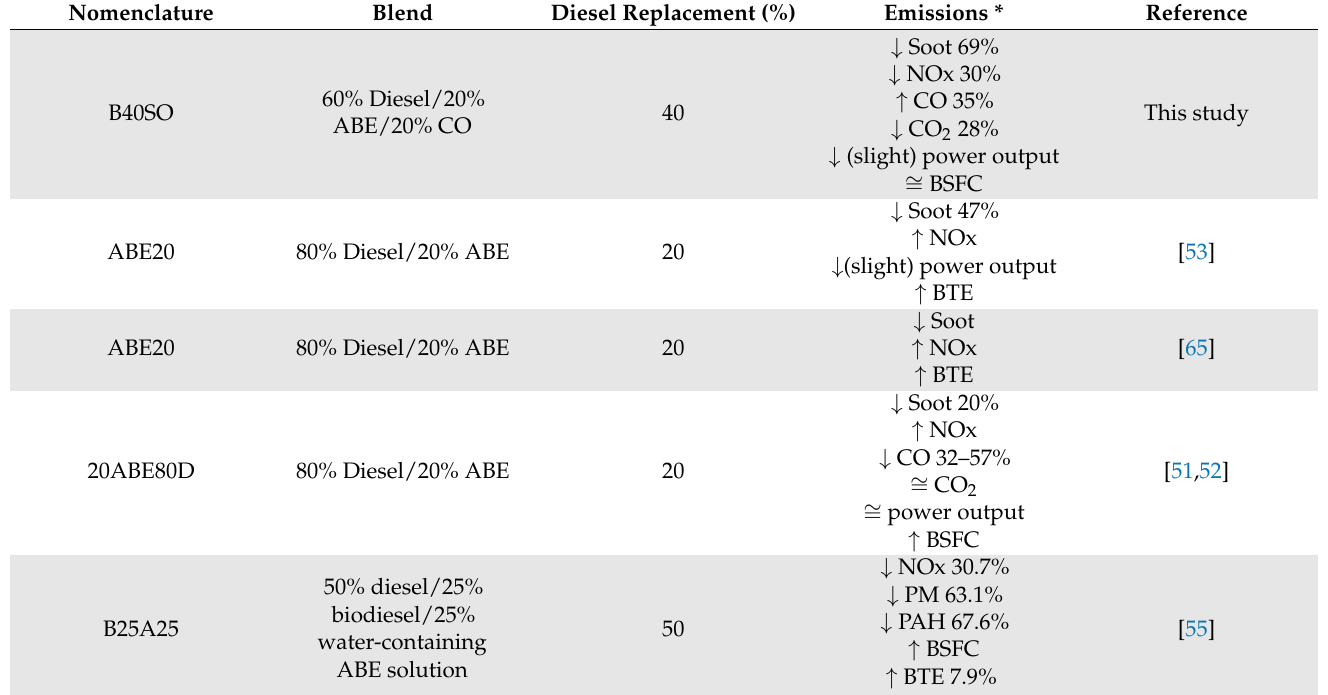
Table 7. Comparison of exhaust emissions generated by a diesel engine fueled with different blends reported in the literature and the percentage of replaced diesel achieved by each of